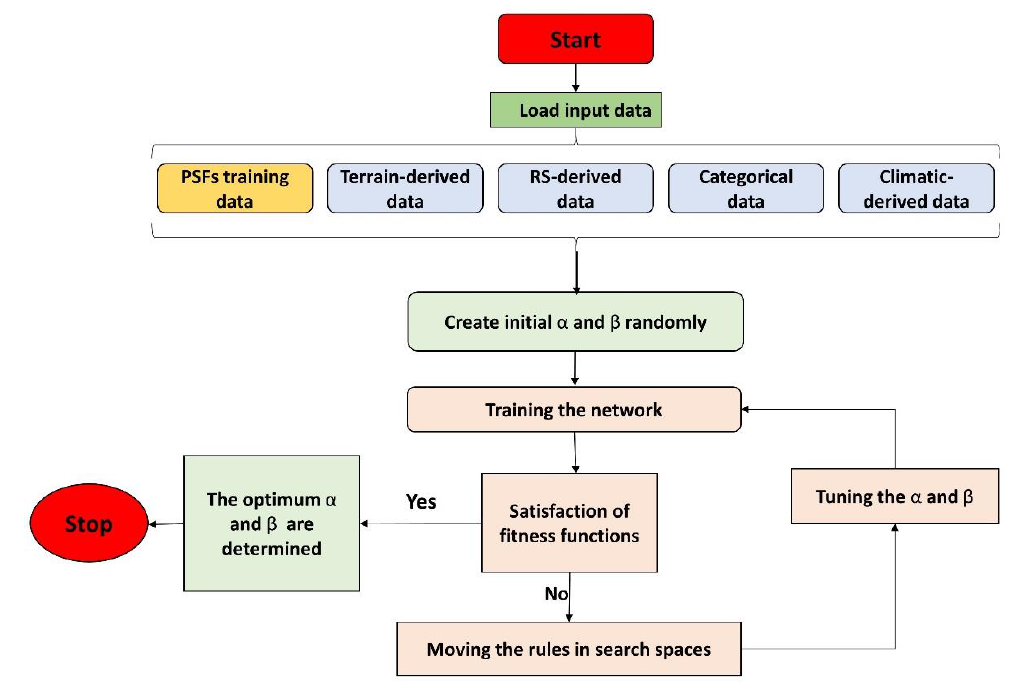
Figure 2. Flowchart diagram of the ANN training using metaheuristic optimization algorithms. α and β represent the weights and biases, respectively.